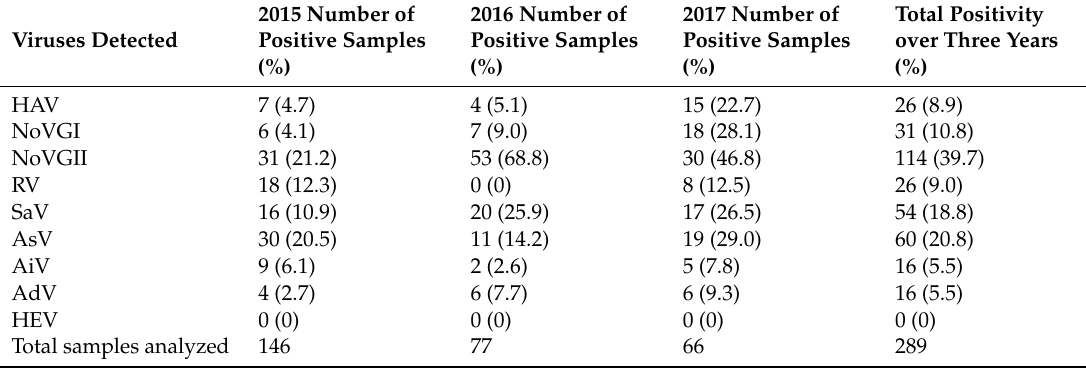
Table 4. Positive results in the samples for various targets during the three-year testing period.